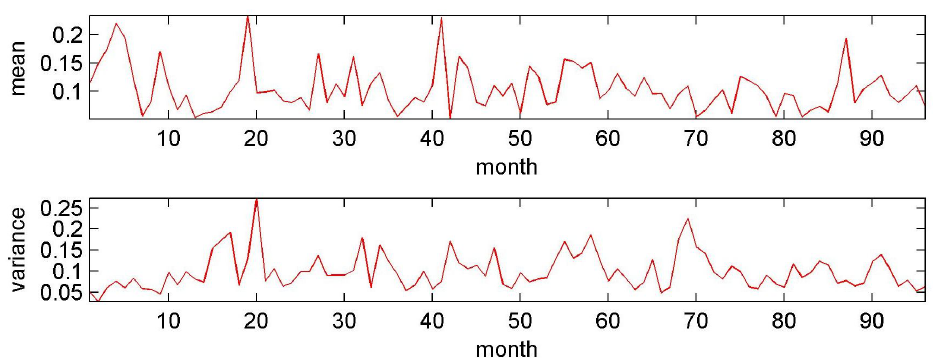
( j ) ( top ) in K and ext